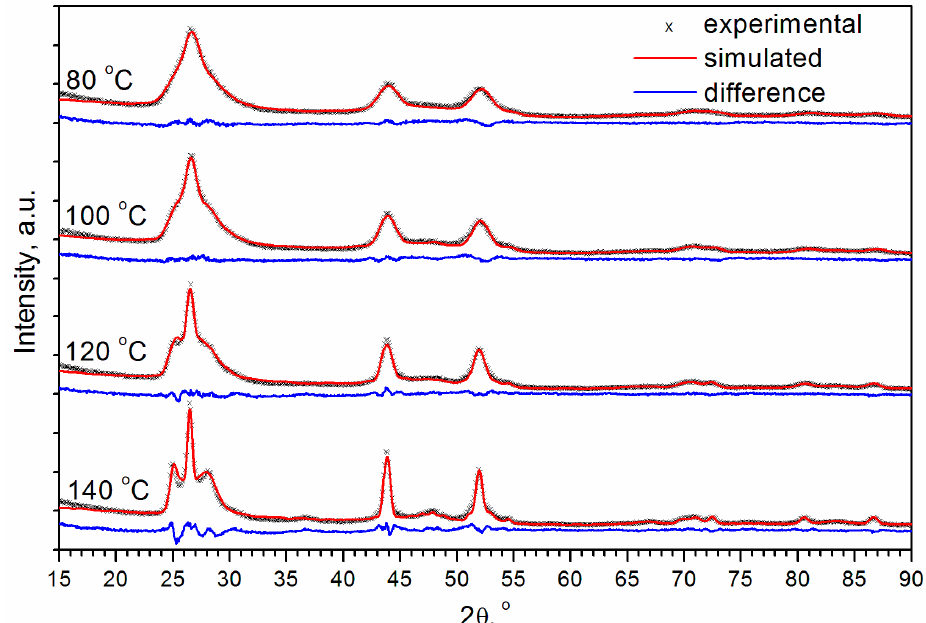
Table 1. Optimized values of probability of SFs in WZ structure ( α ), radii of ellipsoidal particles in ab plane (Rab) and in c direction (Rc) in dependence on temperature T.